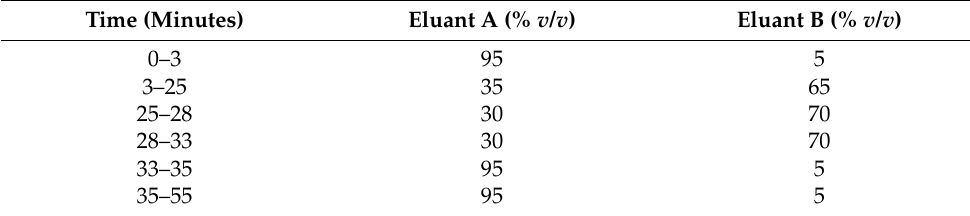
Table 4. Gradient elution for HPLC/HRMS analyses of lysozyme